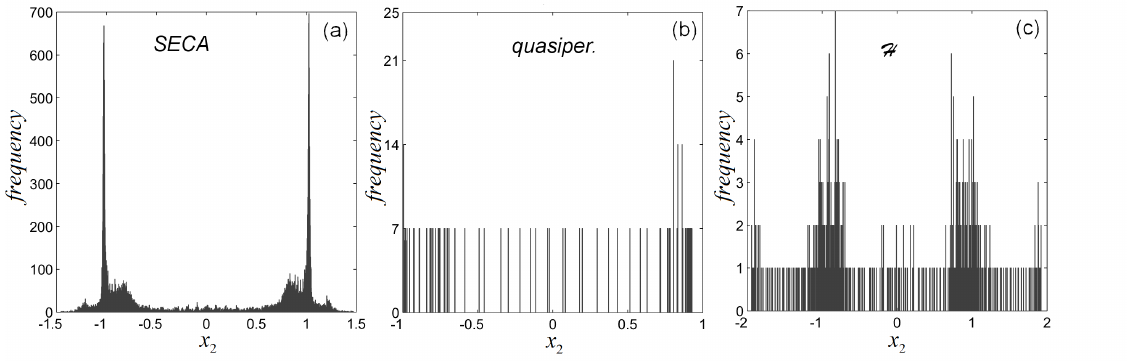
Figure 8. Histograms of the component x 2 . ( a ) The SECA corresponding to b = 0.98; ( b ) the quasiperiodic attractor corresponding to b = 0.25675; ( c ) the HSNA H corresponding to b =